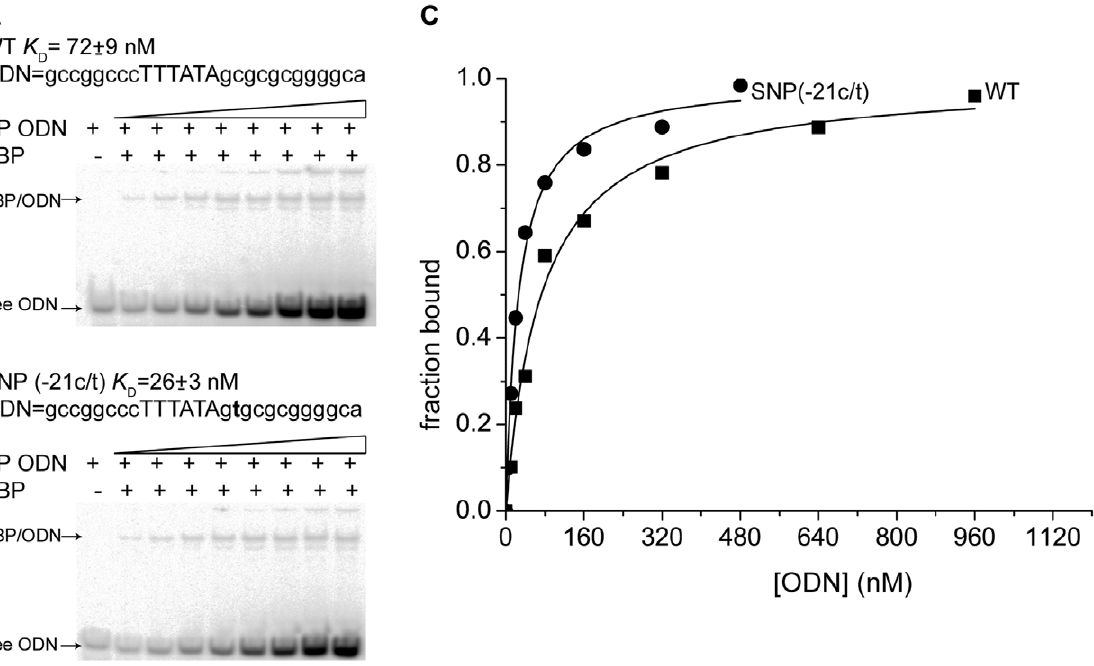
Figure 2. Experimental measurements of the equilibrium K D for hTBP/TATA complexes. The use of an electrophoretic mobility shift assay for measuring hTBP/TATA affinity: ( A ) a TATA-containing ODN in healthy people (the 2 21C allele); ( B ) an ODN with the TATA box containing the SNP associated with myocardial infarction and thrombophlebitis (the 2 21t allele); ( C ) TBP/TATA binding isotherms inferred from electrophoregrams using OriginPro